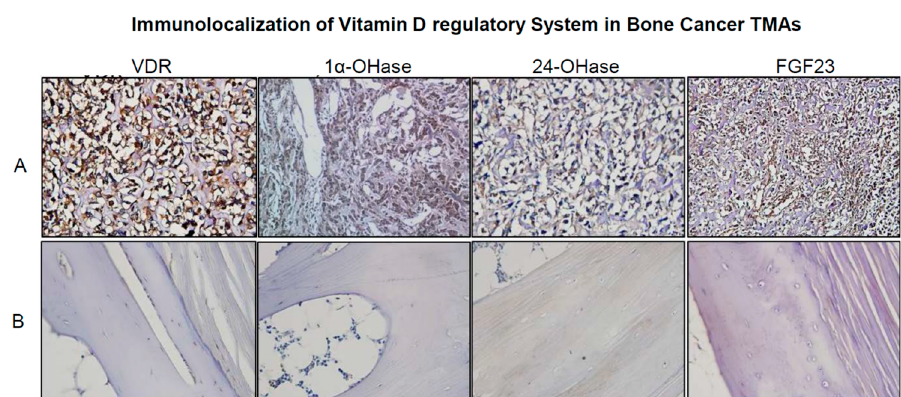
qPCR. Asterisk represents statistical significance of p ≤ 0.05.